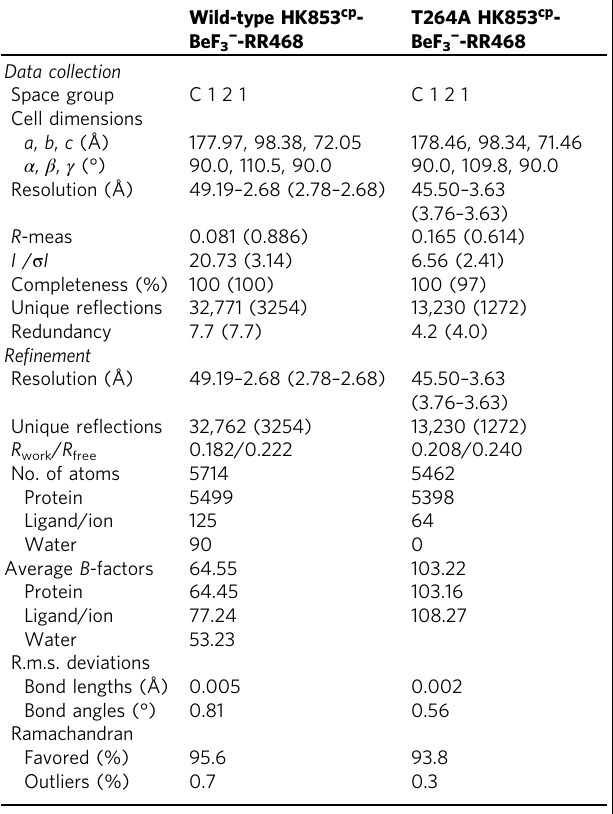
Table 1 Data collection and re fi nement statistics for the wild-type and T264A HK853 cp -BeF 3 − -RR468 complex